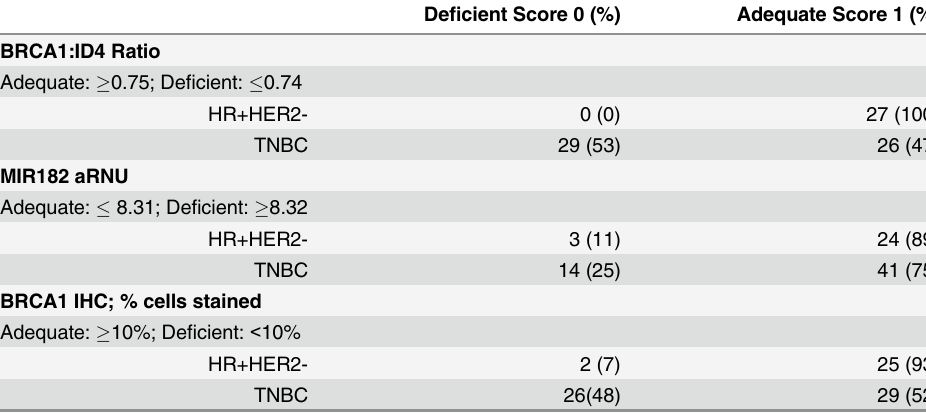
Table 3. Distribution of TNBCs and HR+HER2- tumors adequate and deficient in the three